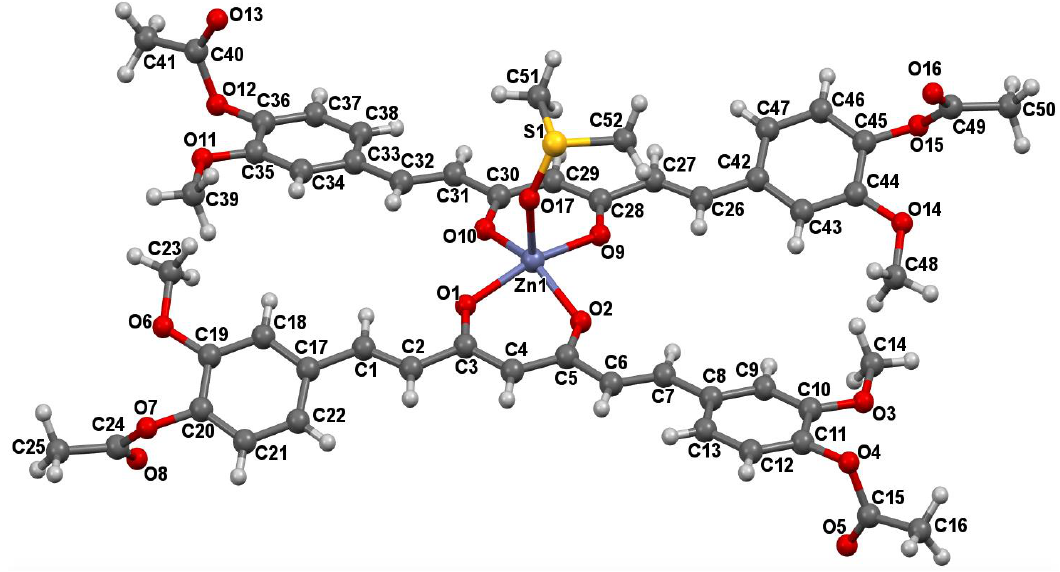
Figure 3. Molecular structure of 3 . Hydrogen atoms are drawn as circles with an arbitrary radius.